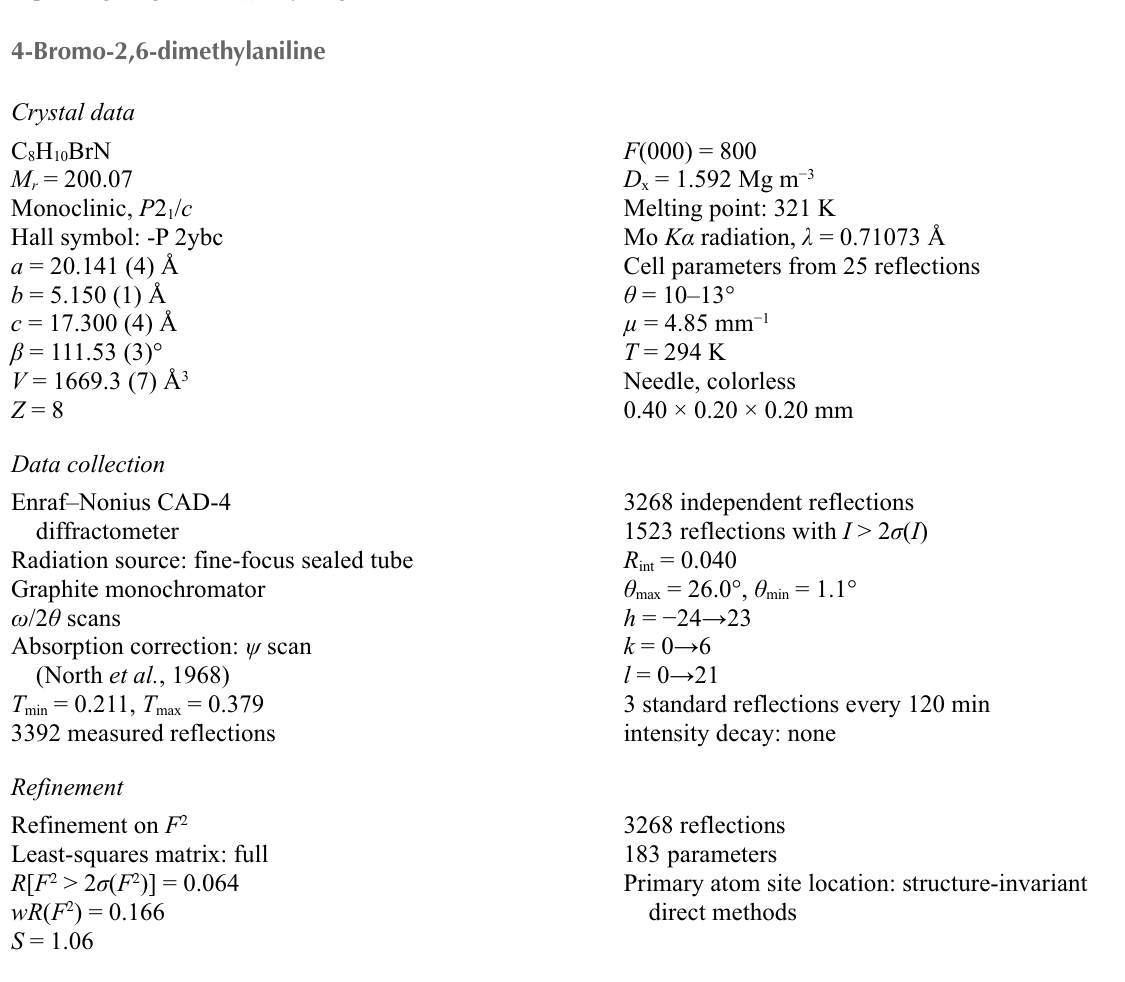
Figure 2 A packing diagram of (I). Hydrogen bonds are shown as dashed